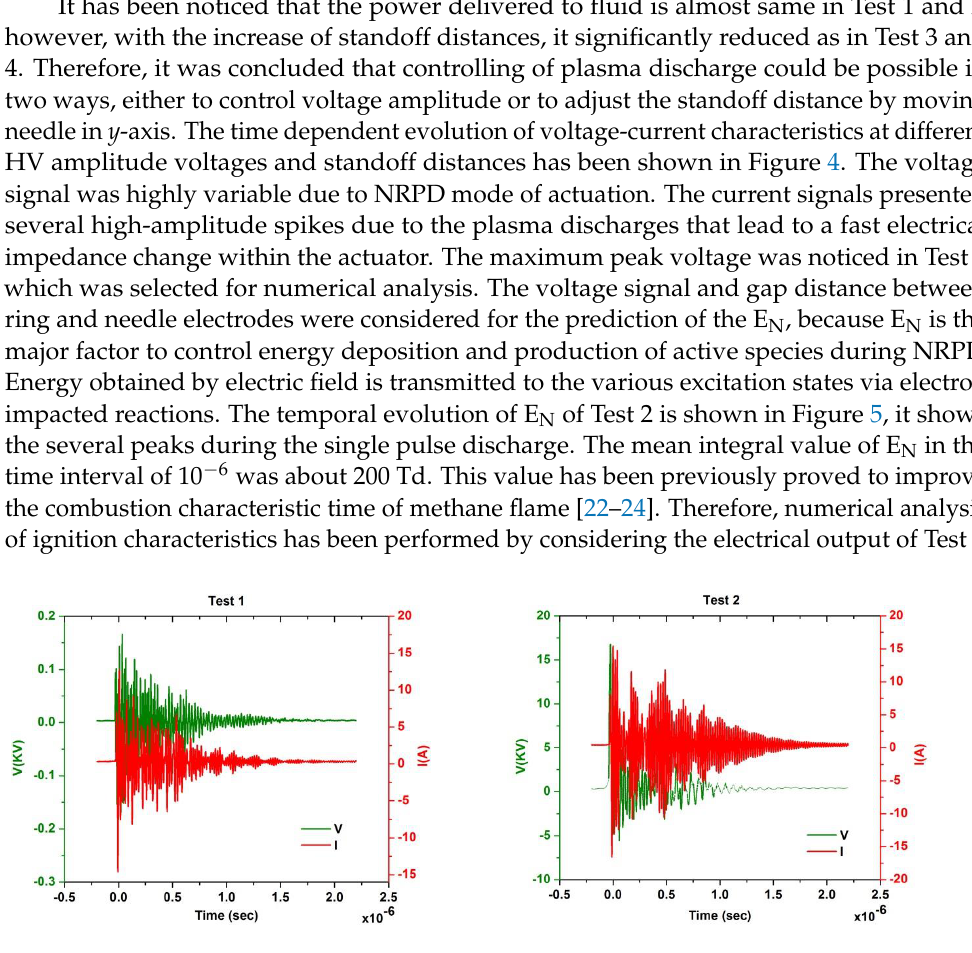
Figure 5. Temporal evolution of experimental E N of Test 2. 4.2. Flow Visualization The smoke flow visualizations have been carried out by using a high-resolution cam- era (MEMRECAM GX-3). An advantage of the flow analysis under quiescent conditions is that it could be possible to better analyze the plasma induced flow due to the momen- tum transfer, which otherwise would be hidden by effects due to the chemical reactions.